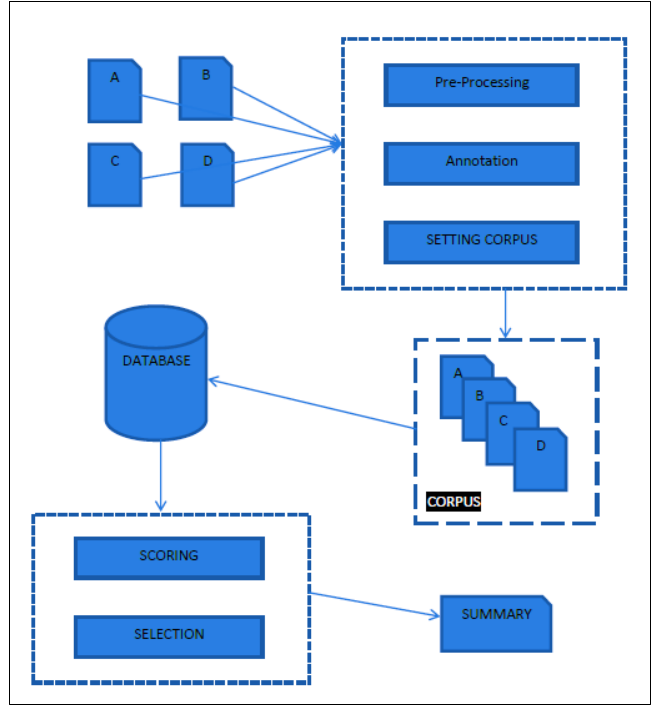
Figure 1. A Framework for Multi-Document Temporal